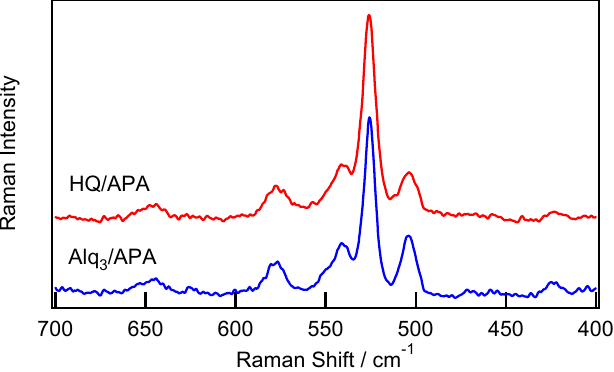
Figure 6. Raman spectra obtained for the HQ/APA (v) and Alq 3 /APA (v) samples in the 400–700 cm − 1 region. The excitation wavelength was 785 nm.